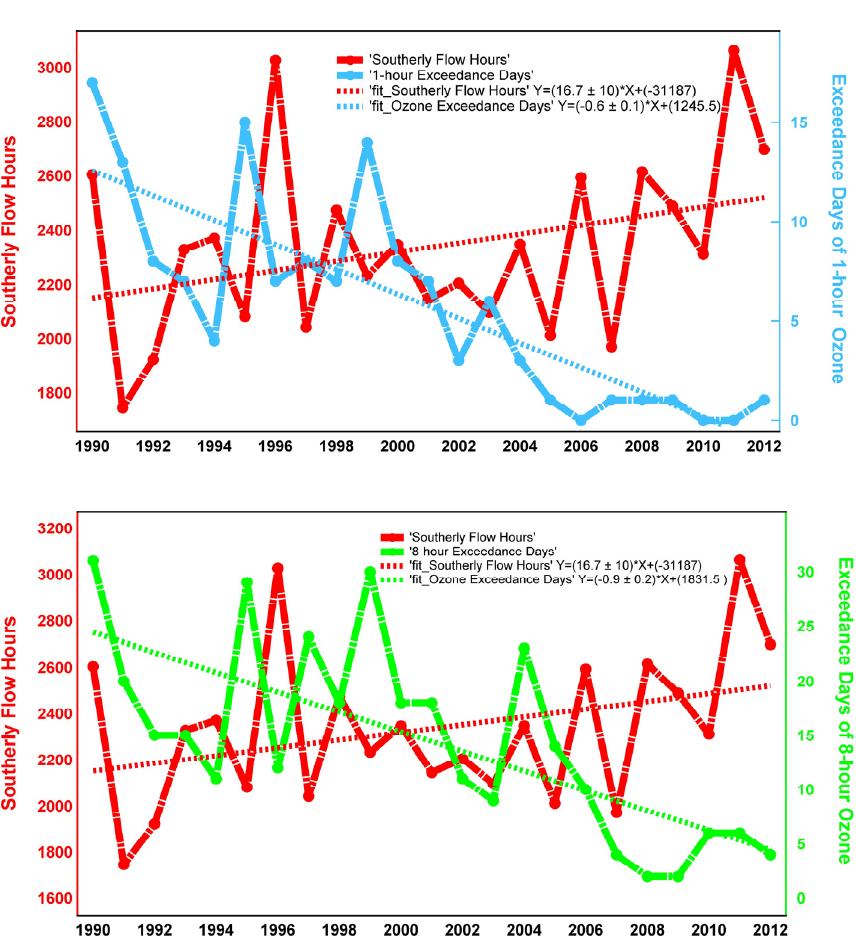
Figure 4. 1-h and 8-h exceedance days as a function of annual southerly flow hours per year at the Clinton